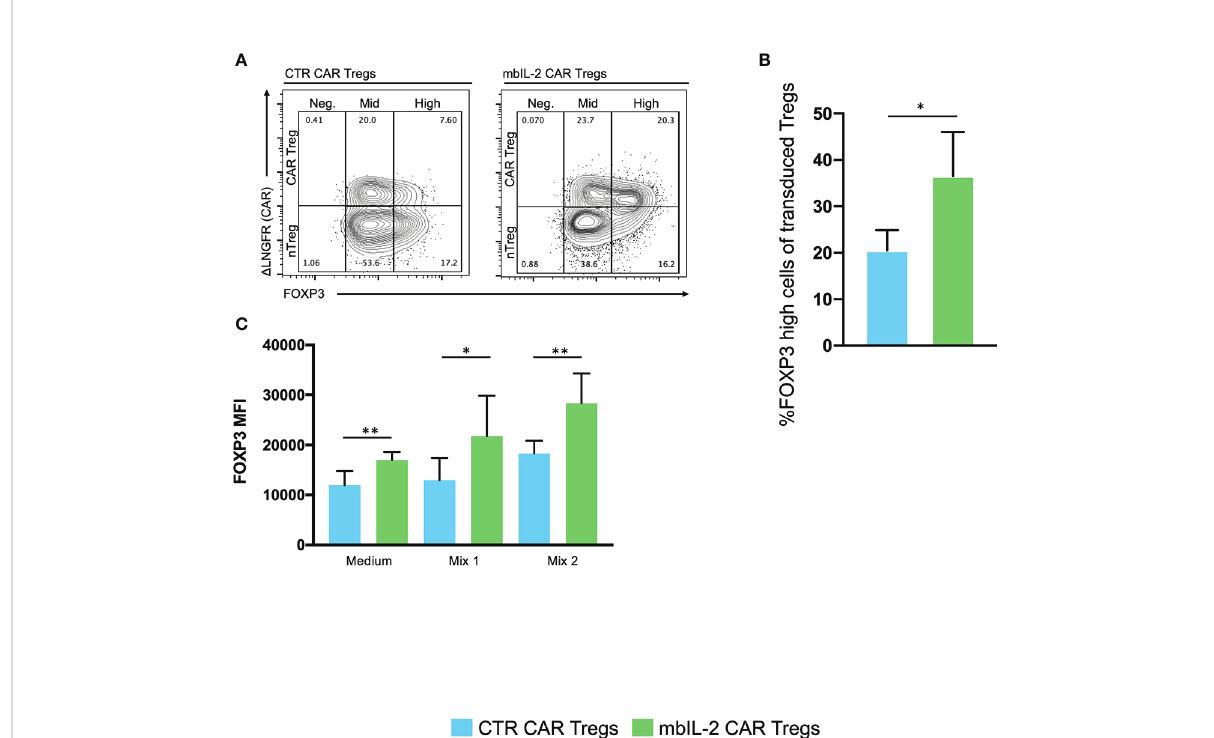
FIGURE 6 Expression of membrane-bound IL-2 resulted in high FOXP3 expression in mbIL-2 CAR-Tregs, protected them from conversion in the presence of the in fl ammatory cytokine mbIL-2 CAR-Tregs and protected them against the adverse effects of Tac in vitro . We analysed the levels of FOXP3 expression in either CTR CAR and nTregs or mbIL-2 CAR and nTregs in coculture assays. This mixed population was divided for the starvation experiment and further cultured under three different IL-2 concentrations (0, 25 U). On the indicated days, the cells were removed and analysed by fl ow cytometry. (A) Representative FACS plots illustrate the gating strategy for CTR CAR and mbIL-2 CAR-Tregs (0 U IL-2) in the starvation experiment with transduced and nontransduced Tregs and their classi fi cation into FOXP3-negative, -mid and -high cells. (B) Bar graph summarizes the percentage of FOXP3high cells within the Treg compartment of CTR CAR and mbIL-2 CAR-Tregs. By day 21, the proportion of FOXP3high cells in the mbIL-2 CAR-Treg compartment was nearly twice (36.50% +/- 9.54%) that in the CTR CAR-Treg compartment (20.50 +/- 4.36). n=4 of different individuals. Signi fi cance was evaluated using an unpaired t test. Error bars show the mean ± SD. *P ≤ 0.05. (C) Bar graph summarizes the mean fl uorescence intensity (MFI) of FOXP3 expression in CTR CAR and mbIL-2 CAR-Tregs in the presence of cytokine mix 1 (IL-2, IL-1ß, IL-6, TGF-ß) and cytokine mix 2 (IL-2, IL-21, IL-23, TGF-ß). mbIL-2 CAR-Tregs showed a signi fi cantly higher FOXP3 MFI than CTR CAR-Tregs (1.3×10 4 +/- 1.8×10 3 vs. 2.2×10 4 +/- 3.2×10 3 , p value=0.0036). In combination with that observed for cytokine mix 2, a signi fi cantly higher MFI level was observed in mbIL-2 CAR-Tregs than CTR CAR-Tregs (1.8×10 4 +/- 1×10 3 vs. 2.8×10 4 +/- 2.4×10 3 ). n=3, 3 different donors; signi fi cance was calculated using an unpaired t test. Error bars show the mean ± SEM. *P ⪬ 0.041, **P ⪬ 0.0035, ns = not signi fi